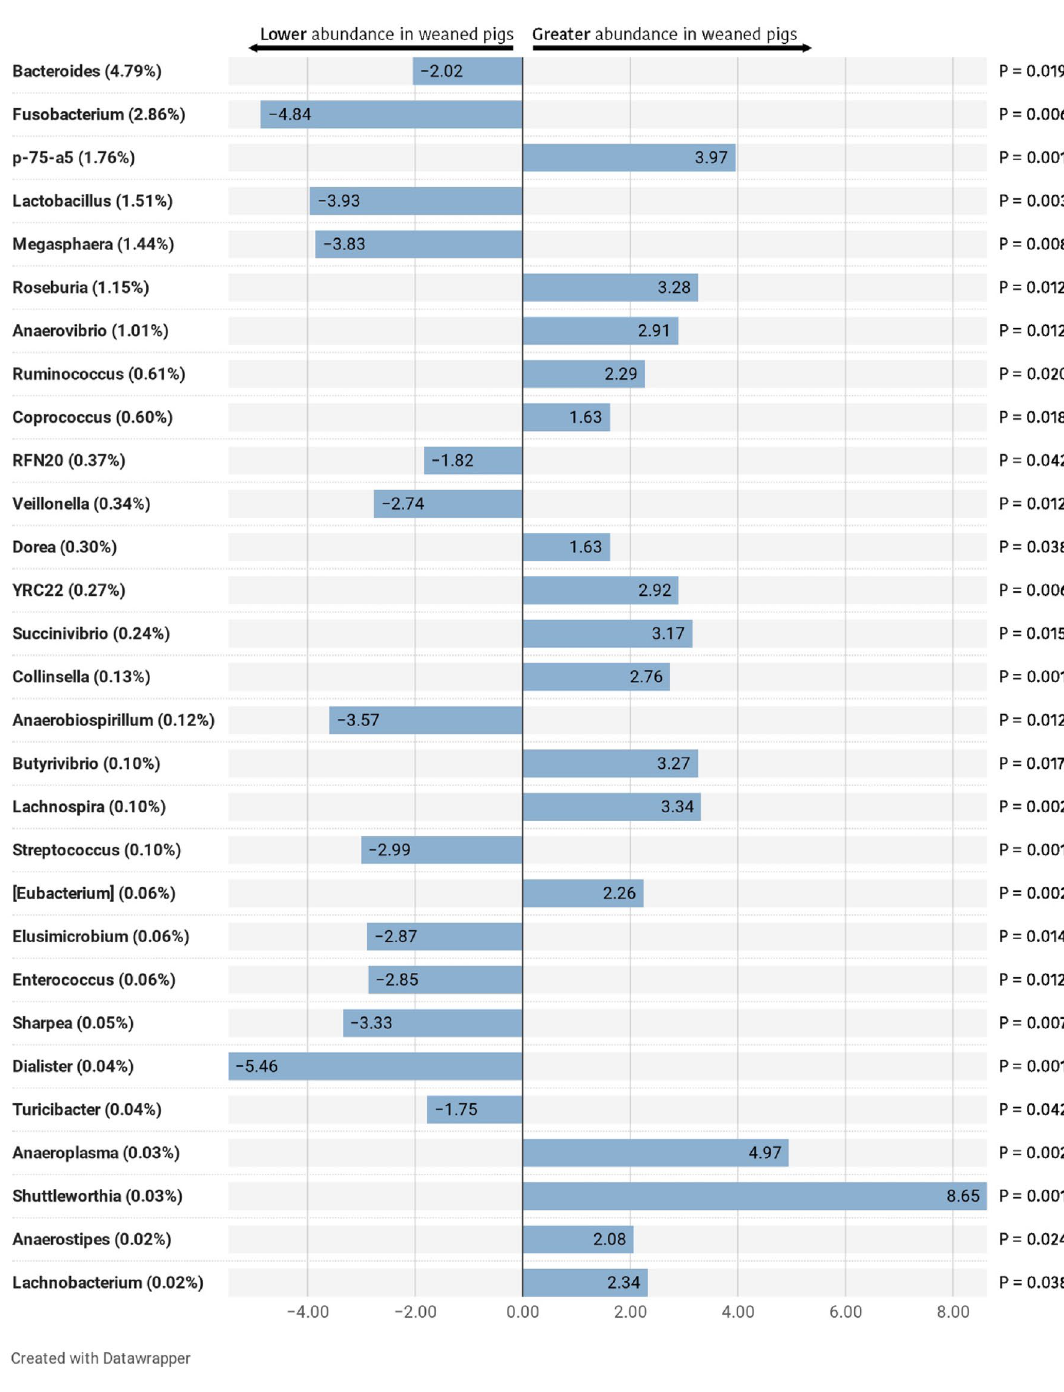
Figure 3. Differentially abundant taxa from caecal content (ln change and adjusted P -value < 0.05) between suckling and weaned piglets at genus level. All significant genera are presented; positive values and negative values indicate greater and lower abundance, respectively, in weaned animals (WEAN group) compared to suckling piglets (LACT); taxa are sorted according to the general mean of relative abundance (the average of LACT and WEAN, indicated between brackets in %) and in decreasing order. Figure created with the online open-source tool Datawrapper (http:// dataw rapper.